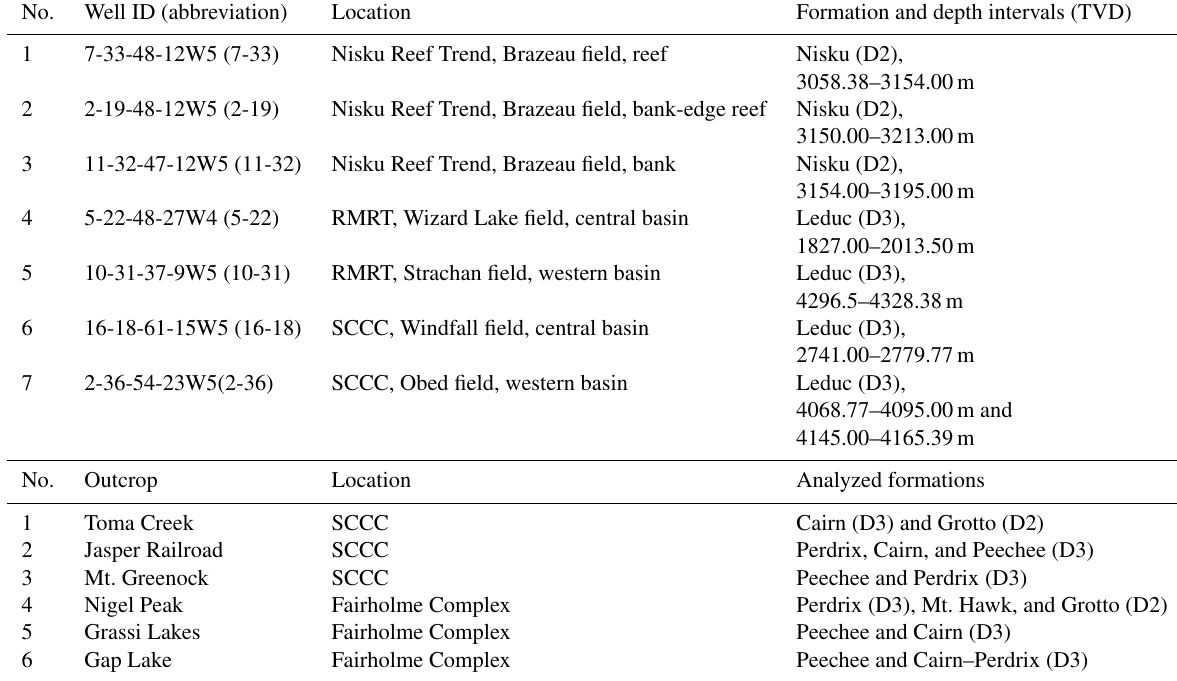
Table 1. Source location of examined cores and